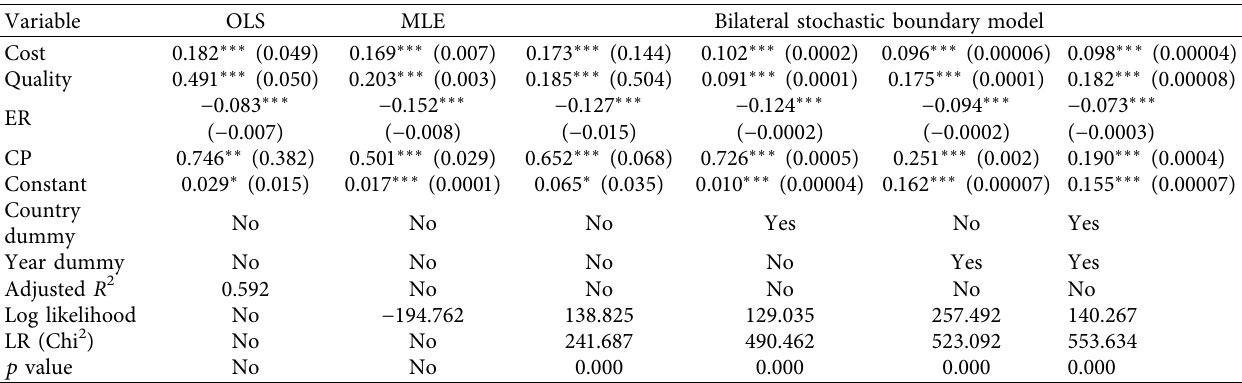
Table 7: Estimation of all